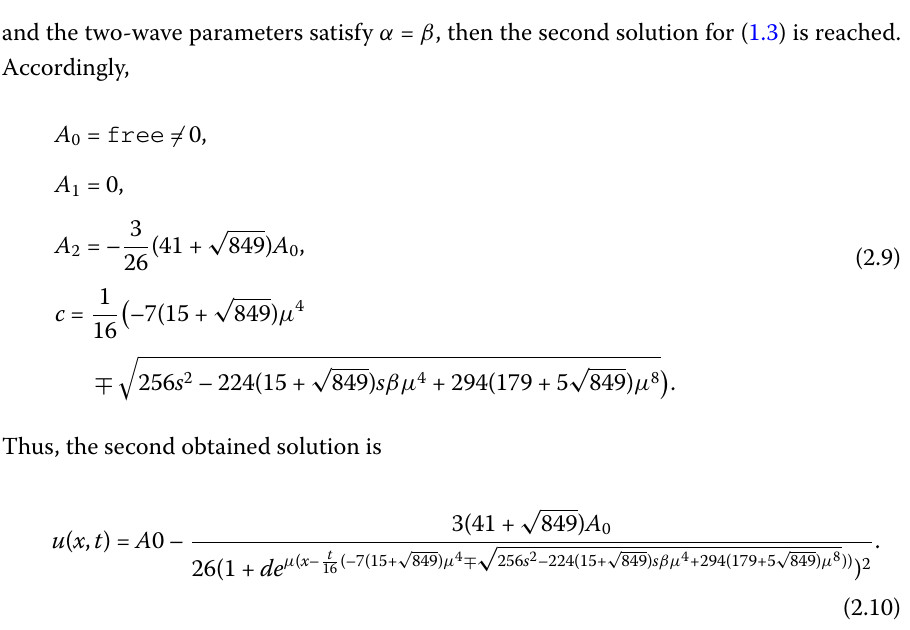
and the two-wave parameters satisfy α = β , then the second solution for (1.3) is